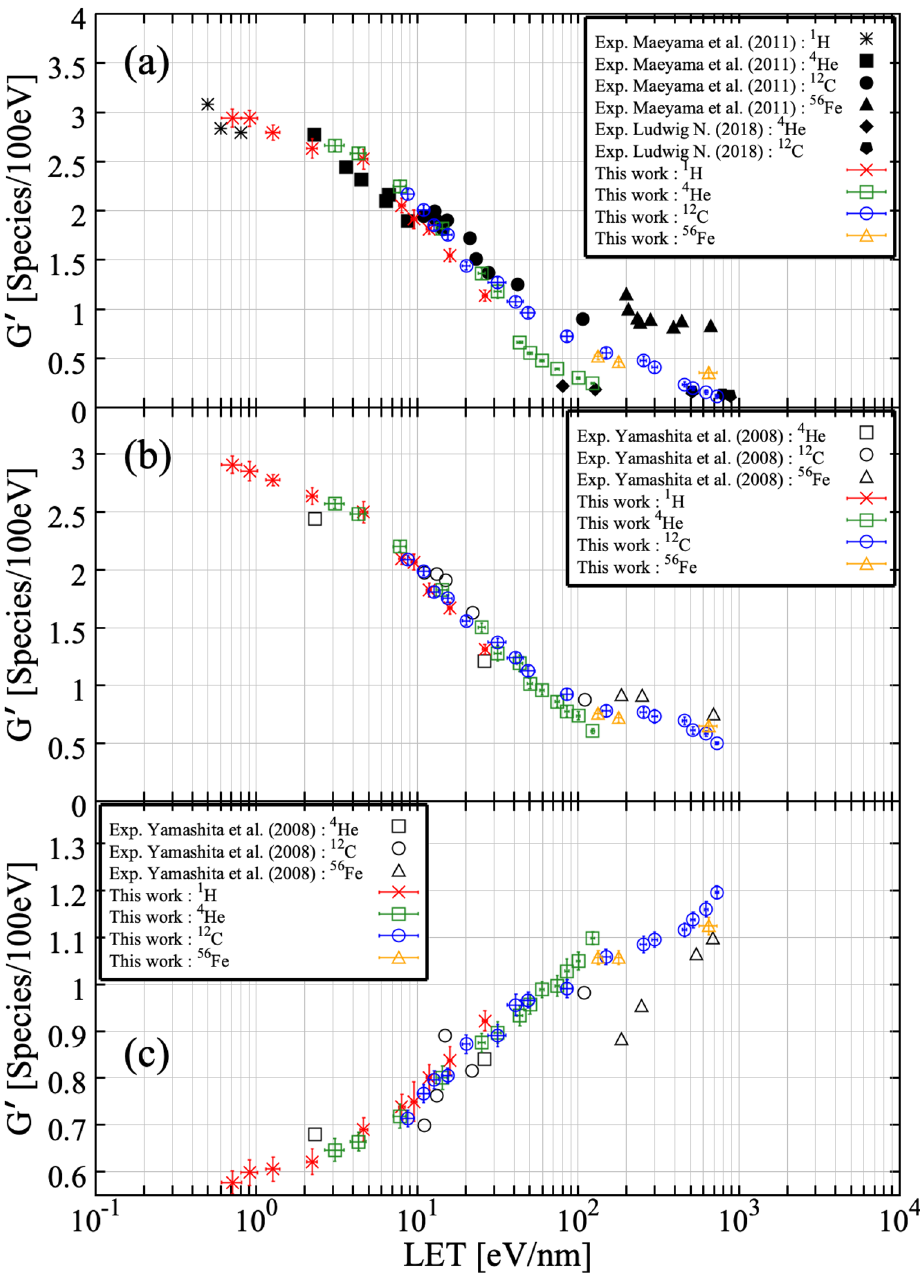
Figure 6. LET dependent G-values of ( a ) · OH, ( b ) e aq− and ( c ) H 2 O 2 at 100 ns after irradiation of a water target with different radiation types. Sets of experimental data presented by Maeyama et al. 10 , Yamashita et al. 7 and Ludwig 17 were used for comparison with simulated LET dependence of